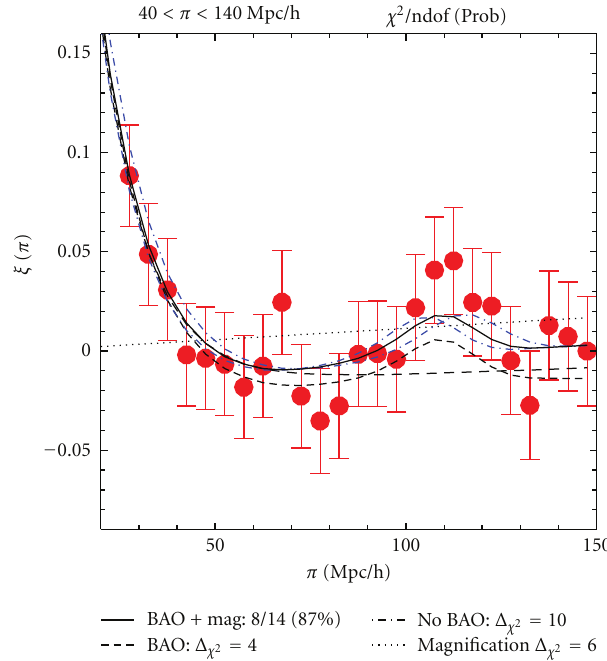
Figure 1: Detection of radial ( π -direction) BAO by [64, Figure 13] in the full LRG sample. This is the correlation pattern along the π - direction and should not be confused with the monopole pattern in Figure 3 of [63]. The e ff ect of weak lensing magnification can bee seen by comparing the solid and short dashed curves, which shows that the magnification systematically moves the peak location towards the higher scales. The dash-dotted (blue) curve shows the 1 σ range by allowing the fiducial distance-redshift relation used in the analysis to vary in a parameterized way, accounting for the systematic error introduced by the mere using of a fiducial